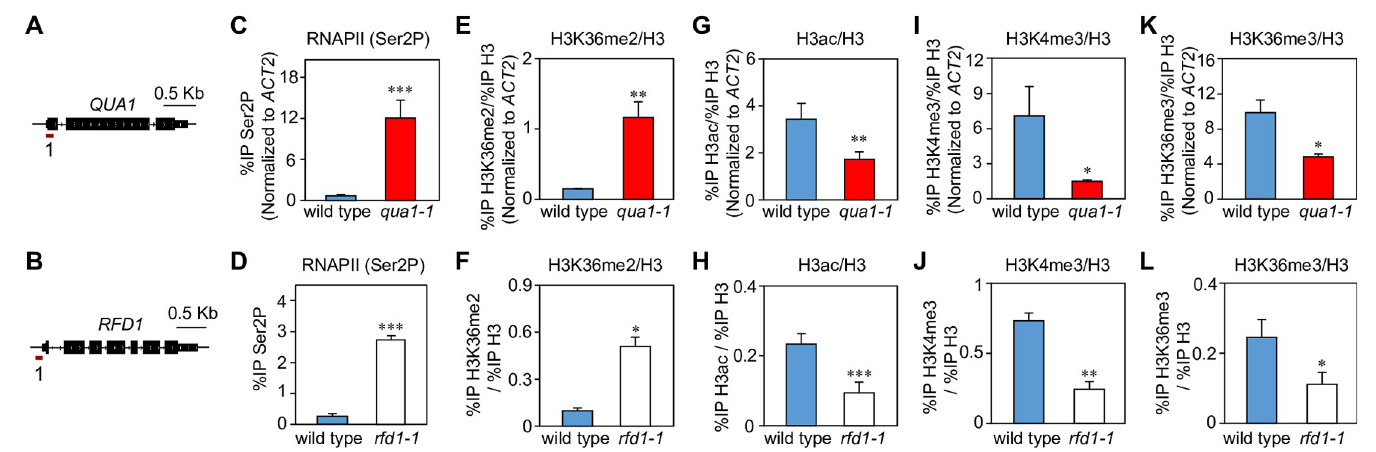
Fig 3. Promoters repressed by upstream transcription adopt RNAPII elongation signatures. (A) Schematic representation of the QUA1 gene, including promoter- proximal primer pair position for qChIP. (B) Schematic representation of the RFD1 gene, including promoter-proximal primer pair position for qChIP. (C-D) qChIP in mutants and their respective wild type ecotypes using promoter-proximal primer pairs for the elongating form of RNAPII (Ser2P). qChIP in mutants and their respective wild type ecotypes using promoter-proximal primer pairs for histone 3 (H3) modifications are shown (E-L). Data are normalized to H3 and show: (E, F) H3K36me2/H3, (G, H) H3 pan-acetylation (H3ac/H3), (I, J) H3K4me3/H3, and (K, L) H3K36me3/H3. Note: For comparisons between wild type (WS) and qua1-1 , qChIP values were normalized to reference gene ACT2 (See methods for more details). Error bars represent standard error of the mean resulting from at least three independent replicates. For statistical tests, a single asterisk denotes p < 0.05, two asterisks denote p < 0.01, three asterisks denote p < 0.001 between samples by Student’s